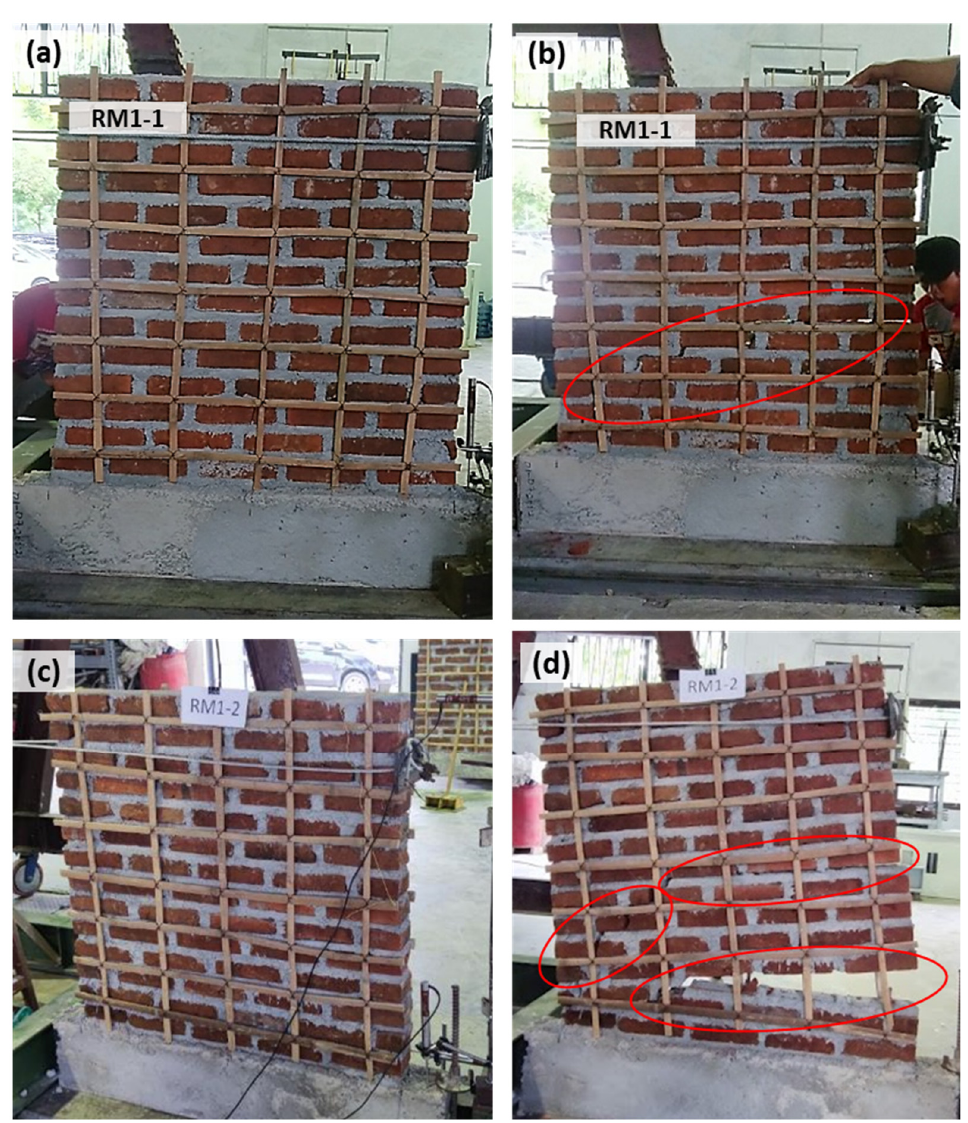
Figure 17. The pushover shear test and crack patterns of the retrofitted masonry panels with 2.88% of bamboo retrofitting: ( a , b ) RM1-1, and ( c , d ) RM1-2.